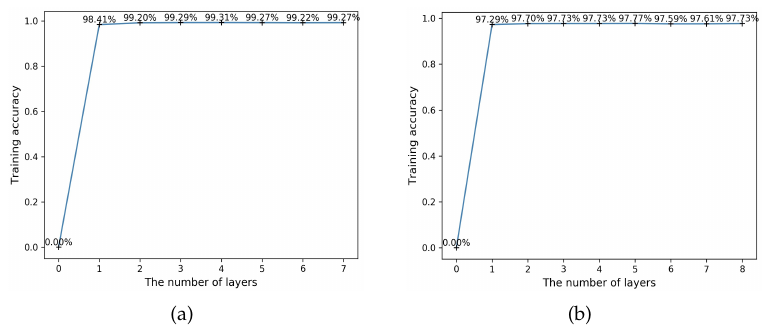
Figure 6. Convergence curves of the proposed model for HAR: ( a ) the convergence curve of handcrafted feature extraction based HAR; and ( b ) the convergence curve of automatic feature extraction based HAR.